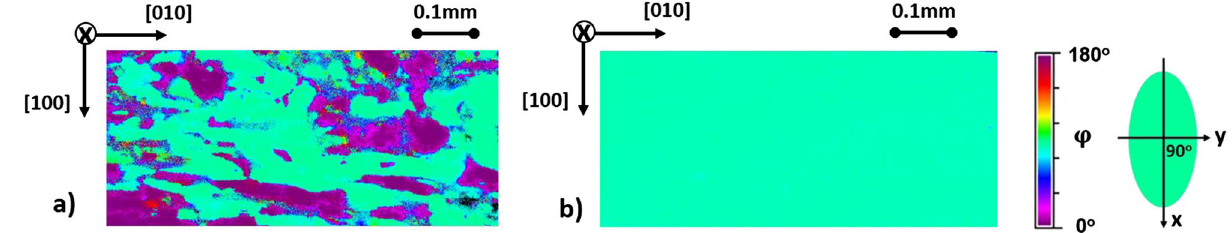
Figure 2. ( a ) Randomly oriented domains before poling in d.c. field. The structure of these domains is analogous to that presented in Ref. 20 . ( b ) Single-domain state after poling in d.c. field represented by homogenous orientation of the optical indicatrix in the crystal. This homogenous orientation, observed after removing electrodes from the surfaces of poled crystal, indicates the permanent state of polarization after all piezoelectric measurements utilizing resonance method (Fig. 3).